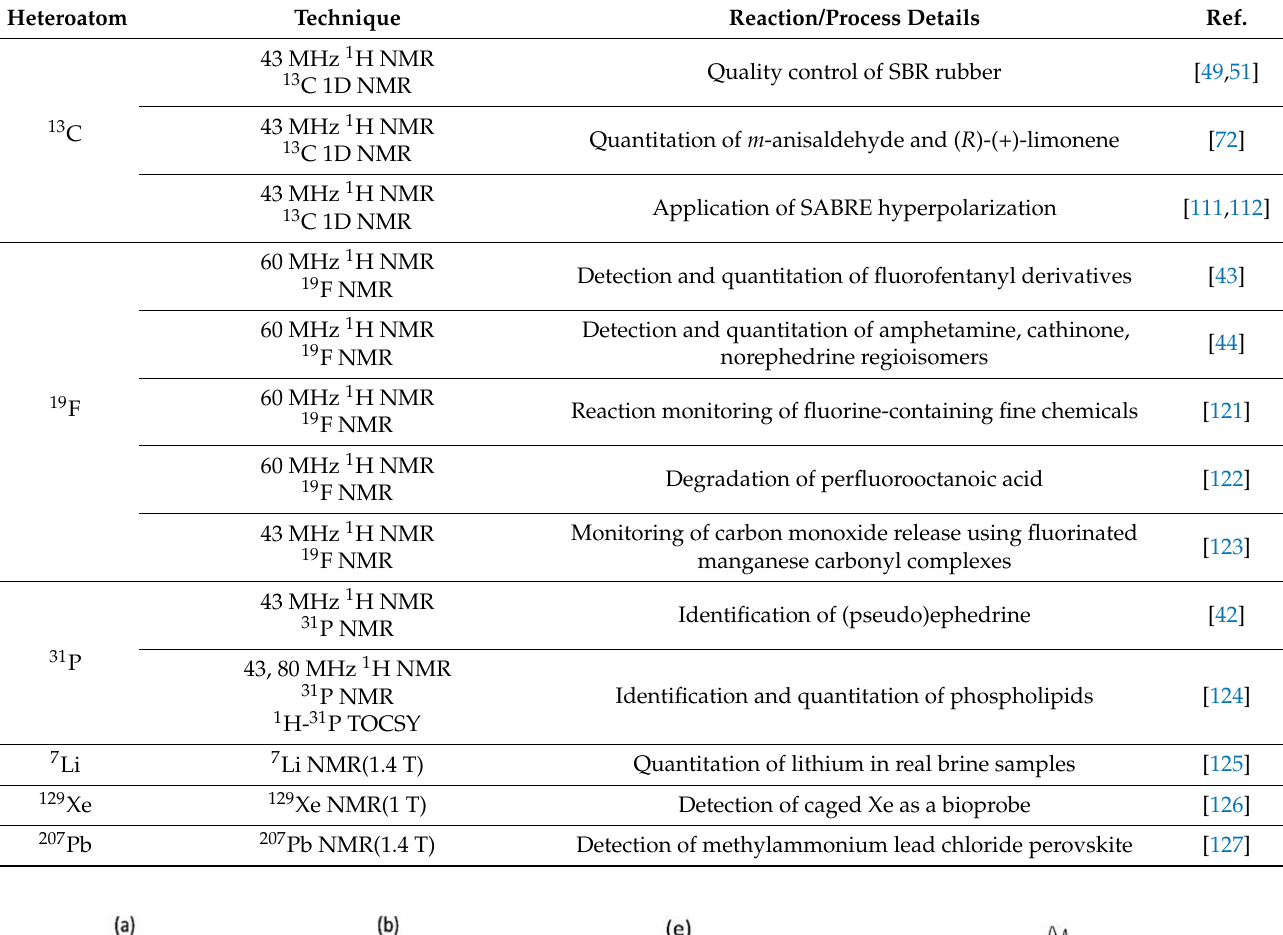
Table 9. Heteroatom-based benchtop NMR spectroscopy methods.